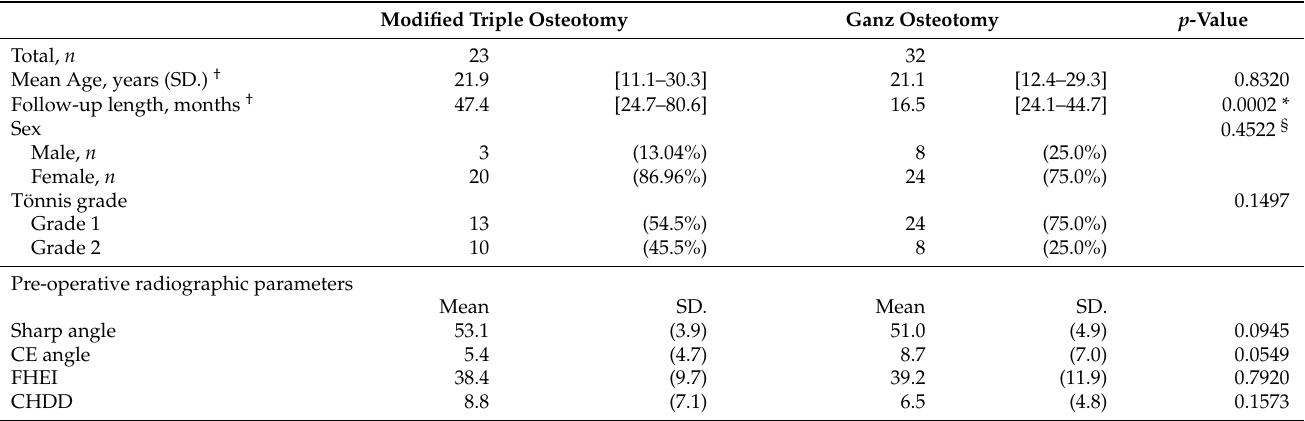
Table 1. Baseline Characteristic Comparison Between Patients Receiving Modified Triple Osteotomy and Ganz